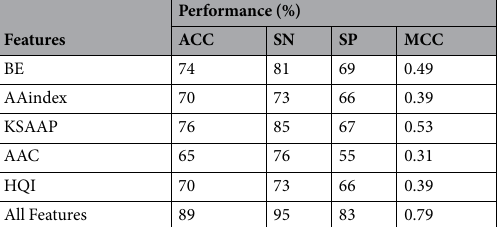
Table 1. Results of 10-fold cross-validation using individual and cumulative